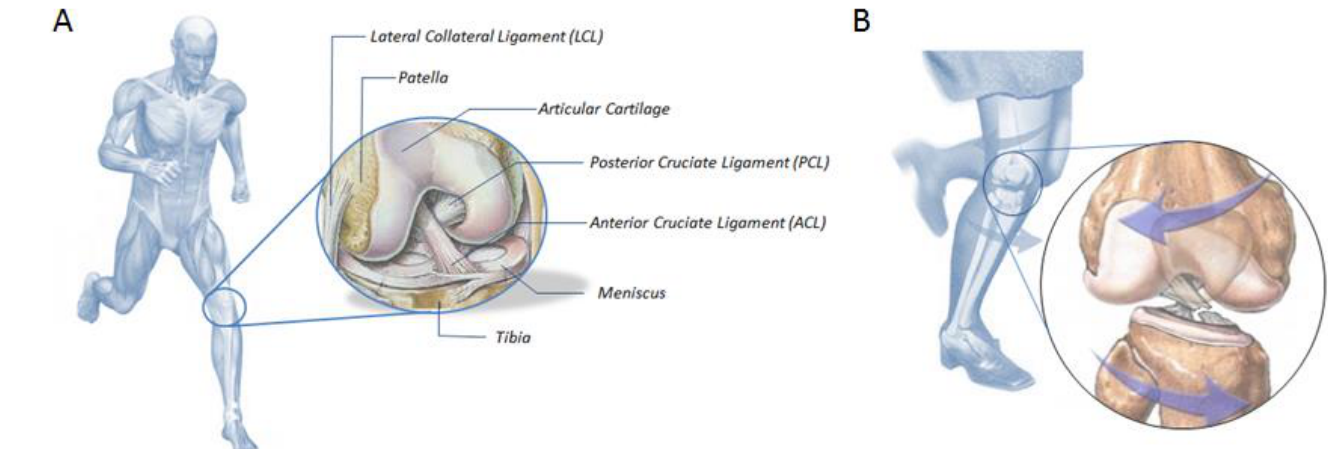
Figure 1. ( A ) Scheme illustrating the ACL location and anatomy. ( B ) An example of knee move- ment leading to an ACL